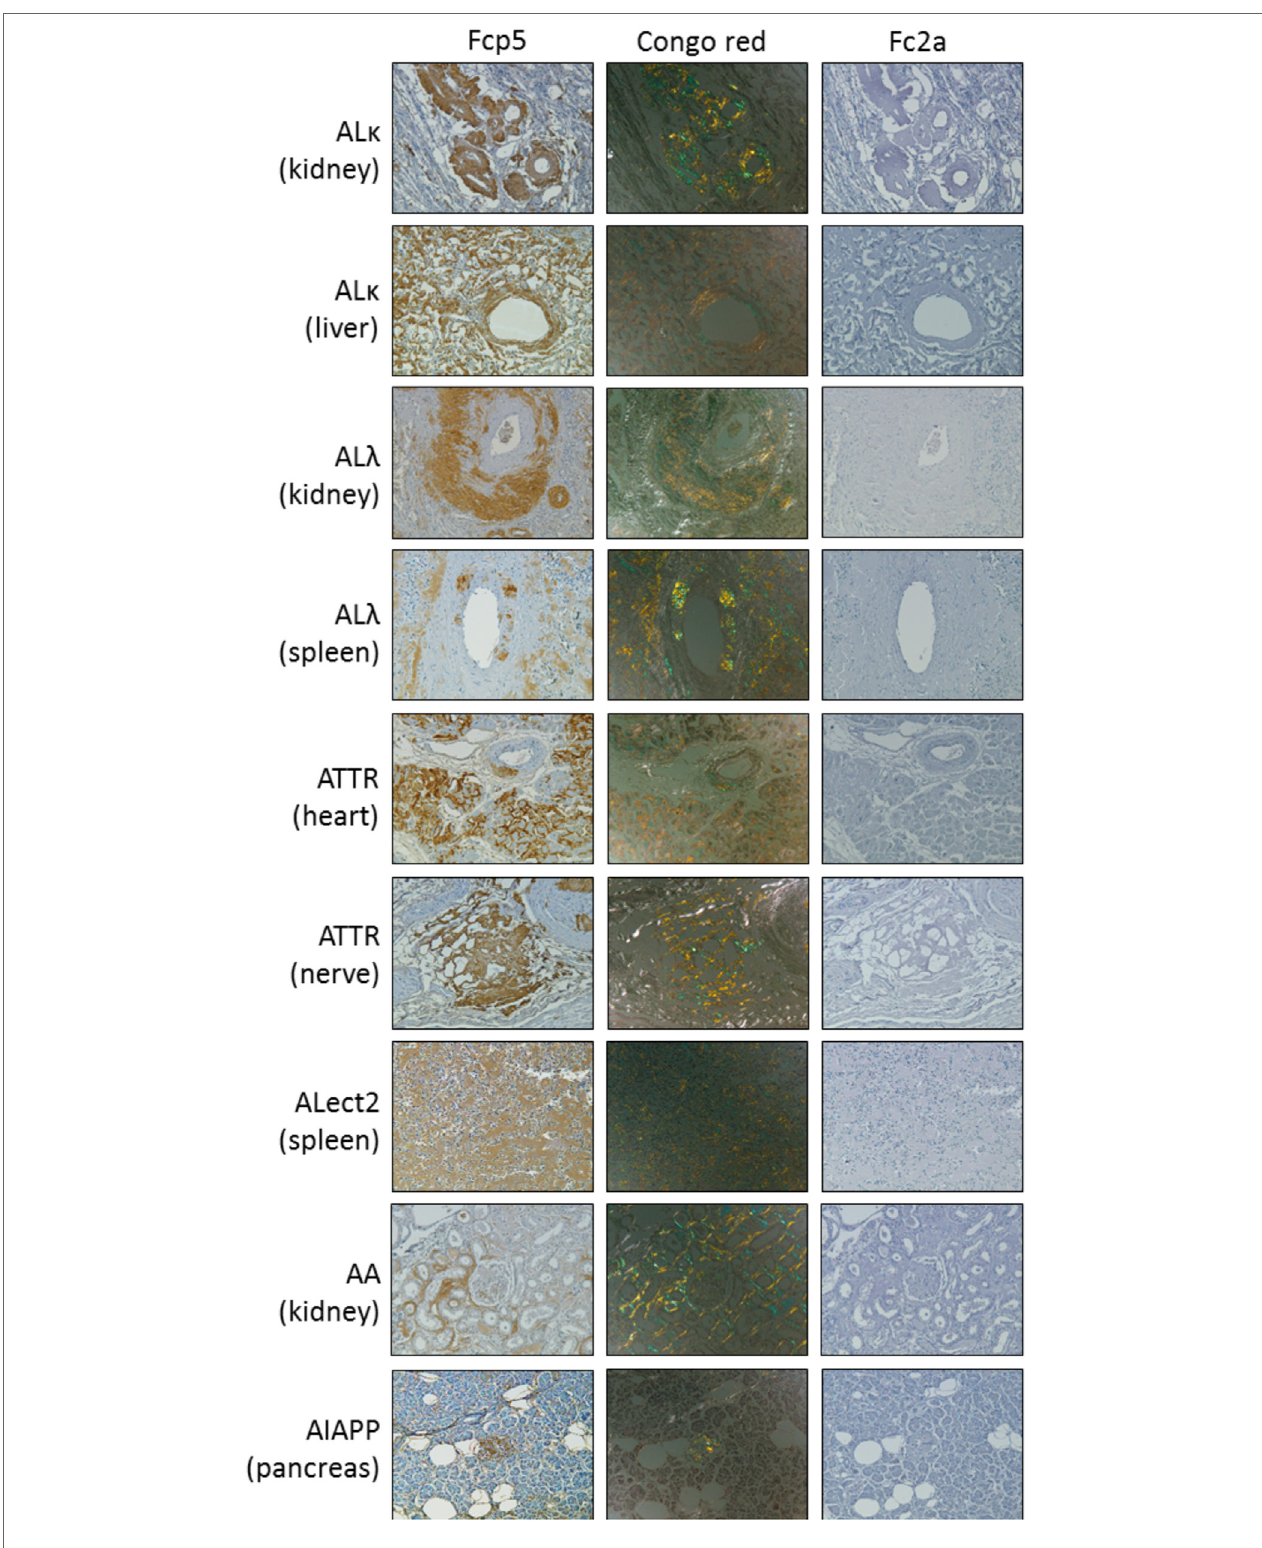
FigUre 3 | The Fcp5 specifically binds human amyloid deposits in formalin-fixed tissues. Fcp5 immunostained human AL κ , AL λ , ATTR, ALect2, AA, and AIAPP amyloid in formalin-fixed paraffin-embedded tissues as evidenced by the brown DAB staining which co-localized with the amyloid seen as green-gold birefringent material in Congo red-stained consecutive tissue sections. There was no binding of Fc2a. Original objective magnification 20 × .